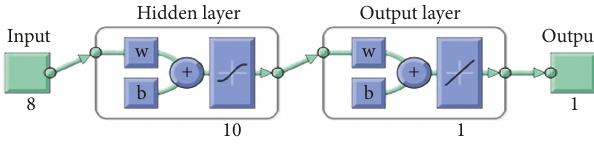
Figure 20: System architecture of the neural network.